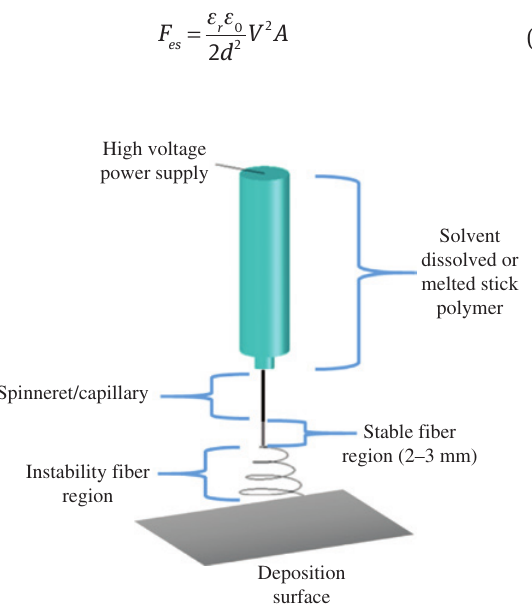
Figure 3: Traditional electrospinning schematic. Solvent-dissolved or melted polymer is fed through a syringe to the spinneret. As polymer reaches the spinneret tip, the initiated voltage creates an electrostatic force that pulls polymer from spinneret to electrode deposition surface. Fiber path is initiated with a stable region for approximately 2–3 mm before the polymer jet becomes unstable and causes lateral perturbations prior to fiber placement.